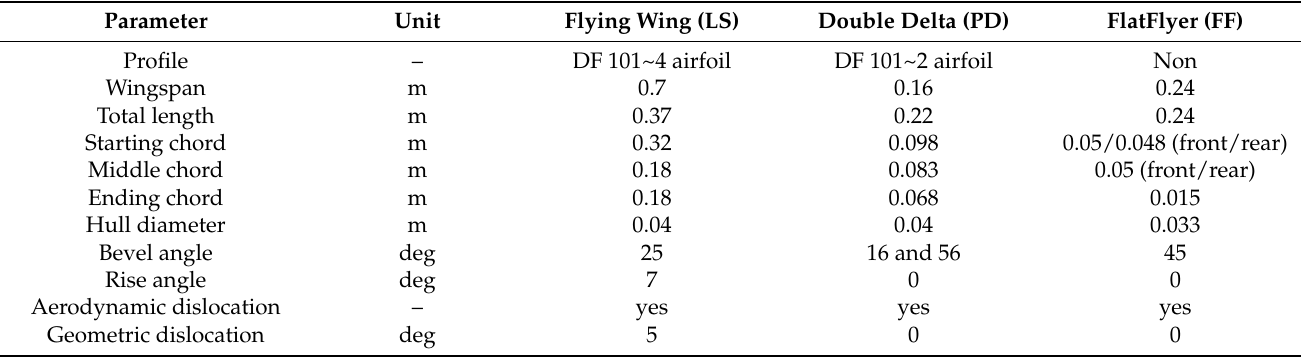
Table 2. Basic parameters of LS, PD and FF